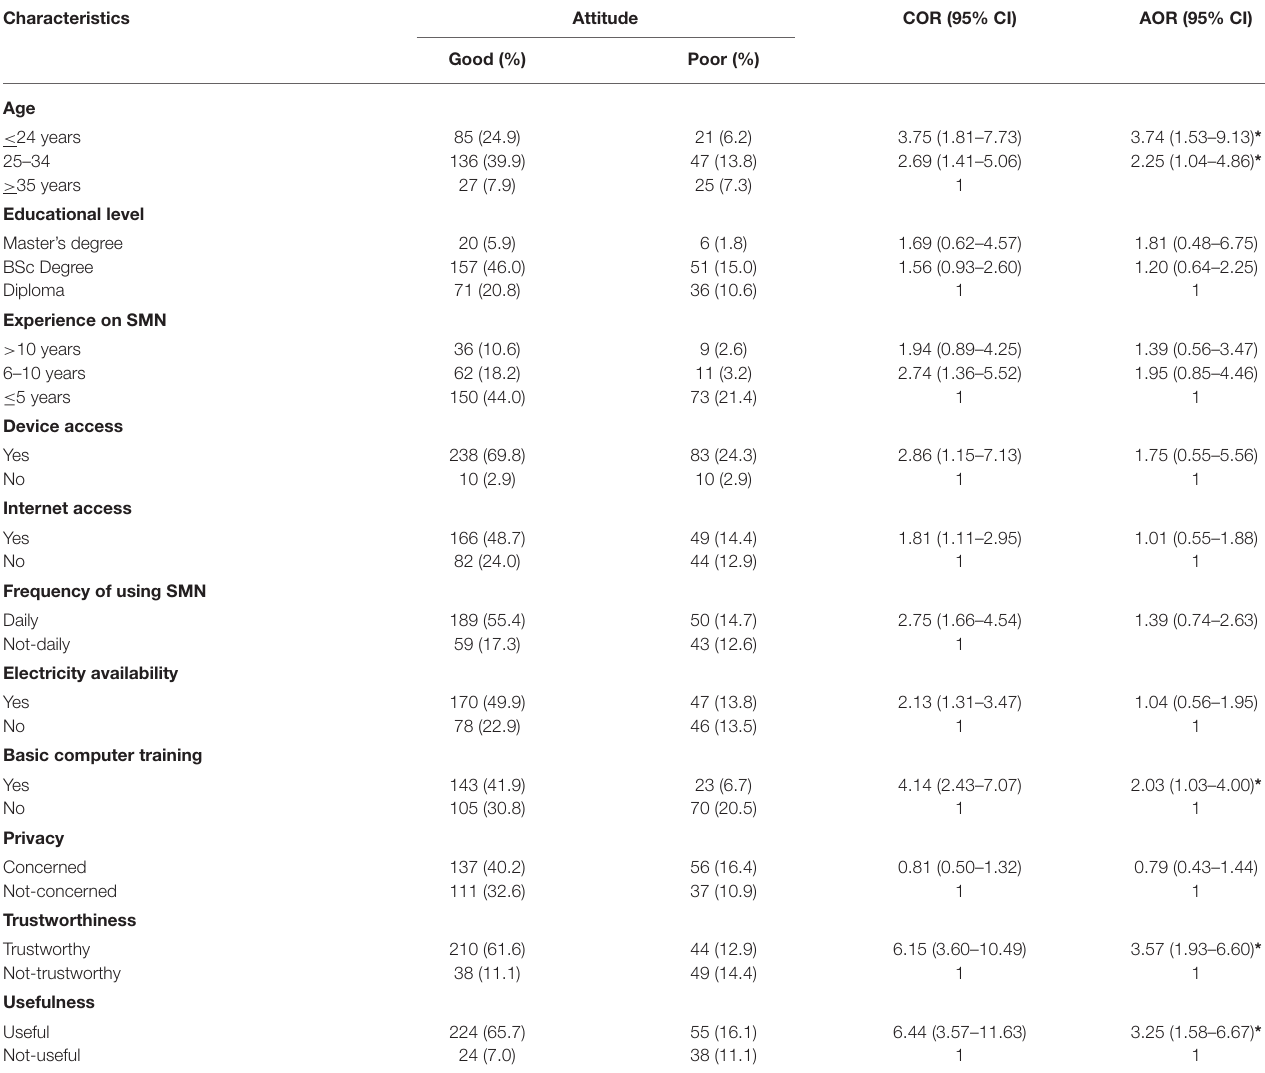
TABLE 5 | Factors associated with health professional’s attitude toward the use of social media for COVID-19-related information at Bahr Dar city health centers ( n = 341).